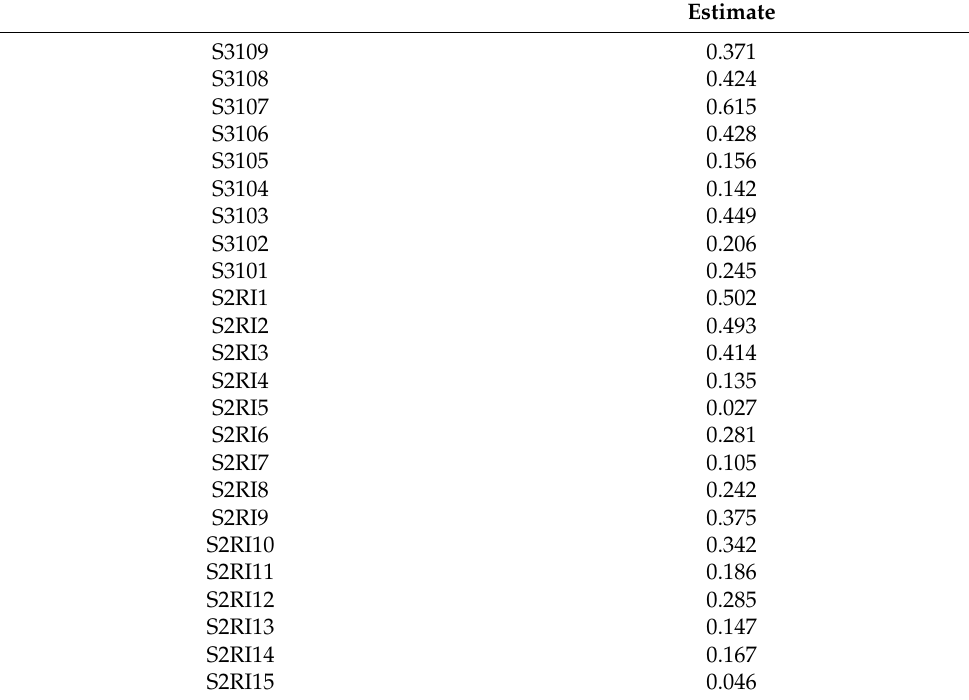
Table A2. Showing squared multiple correlations in the modified